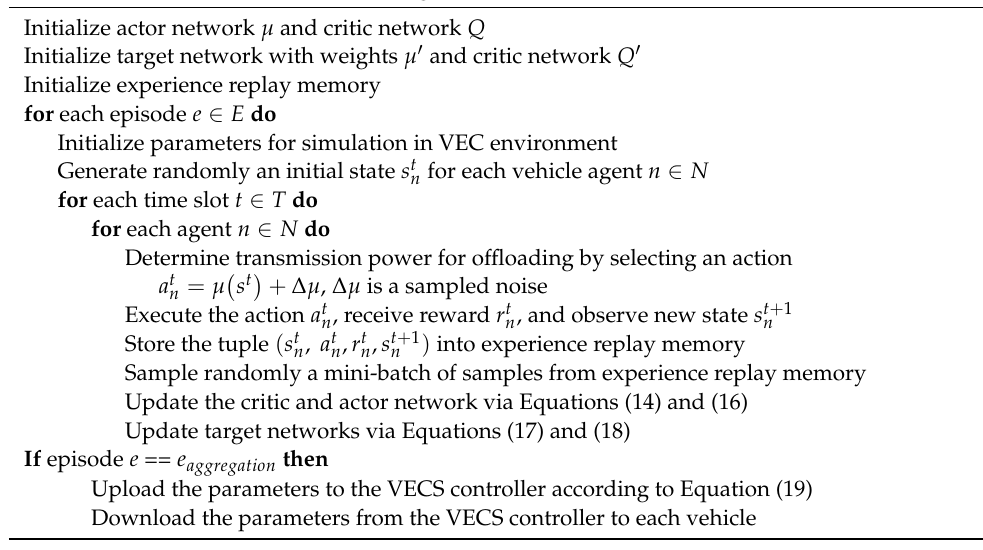
Algorithm 1 FL-DDPG-based Offloading Method